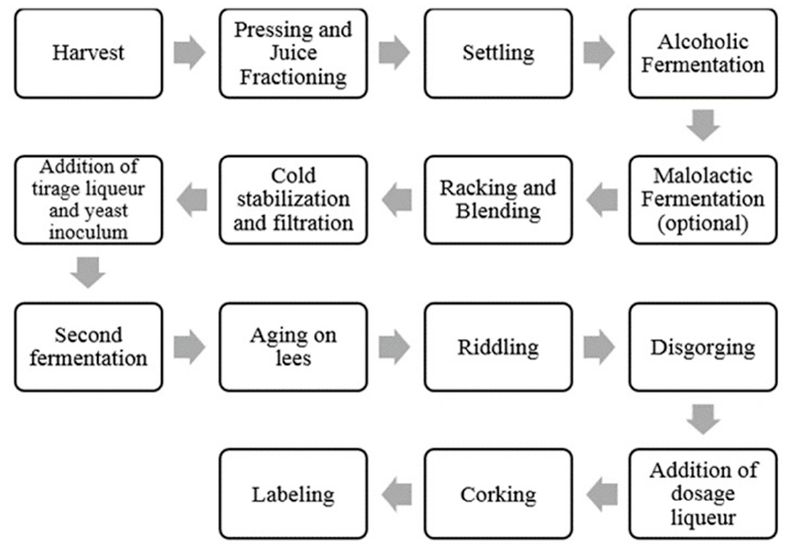
Figure 1. Traditional method sparkling wine flowchart that depicts the steps of production, which described in Section 1 of this review.